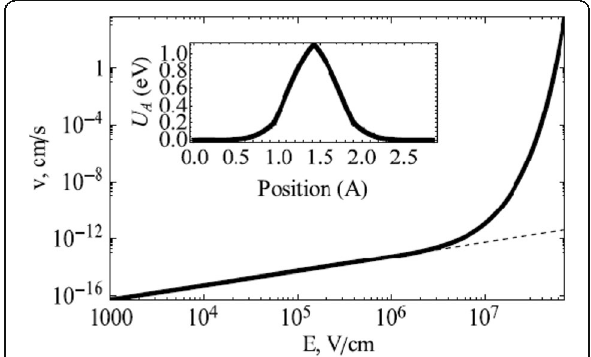
Fig. 5 Nonlinear (solid) and linear (dashed) drift velocity of doubly charged oxygen vacancies along the [110] plane direction in rutile structure at room temperature